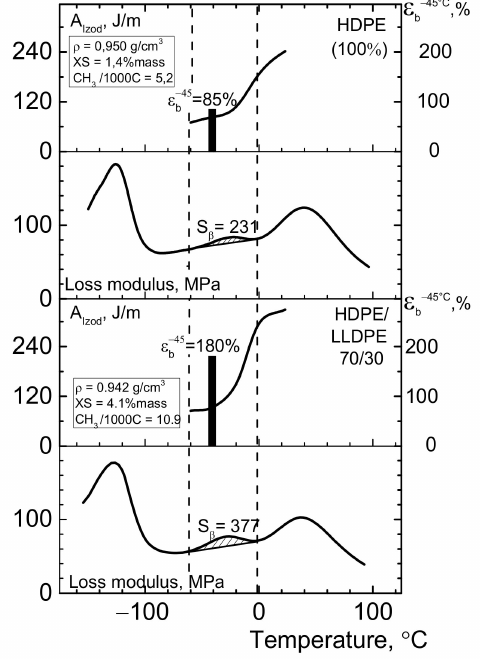
Figure 16. The results of DMA of HDPE, LLDPE, and their blends.